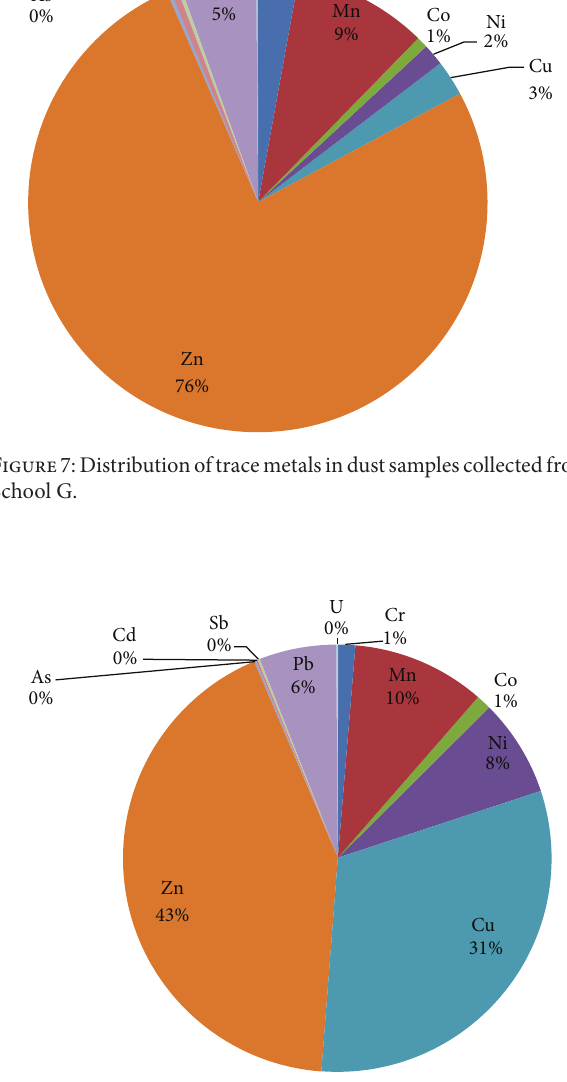
Figure8:Distributionoftracemetalsindustsamplescollectedfrom School